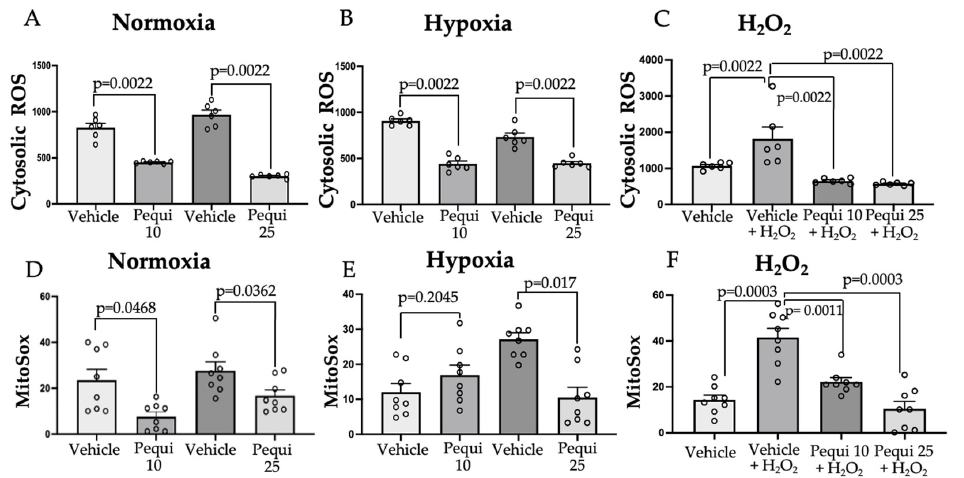
Figure 4. Cytosolic ( A – C ) and mitochondrial ( D – F ) Reactive Oxygen Species (ROS) production in human coronary artery endothelial cells (HCAEC) subjected to normoxia, hypoxia, and H 2 O 2 . HCAEC (1 × 10 4 cells/well) were pre-treated with 0 (vehicle control), 10, or 25 µ g/mL of pequi extract for 24 h, followed by 48 h of normoxia ( A , D ), hypoxia ( B , E ), or six-hour exposure to 100 µ M of H 2 O 2 ( C , F ). Pequi extract decreased cytosolic ROS production in all treatments and concentrations as compared to controls ( p < 0.05). The trend was similar for mitochondrial ROS, except for the pequi 10 µ g/mL treatment in hypoxia conditions, where mitochondrial ROS were not significantly different from vehicle control without extract. Vehicle = Dimethyl sulfoxide (DMSO); Pequi 10 = 10 µ g/mL; Pequi 25 = 25 µ g/mL. Statistical analyses were performed using Mann–Whitney’s test. The results shown represent n = 6 ( A – C ) or n = 8 ( D – F ) independent experiments, using 5 replicates for each experiment/condition. MitoSox: Mitochondrial Superoxide Indicator.